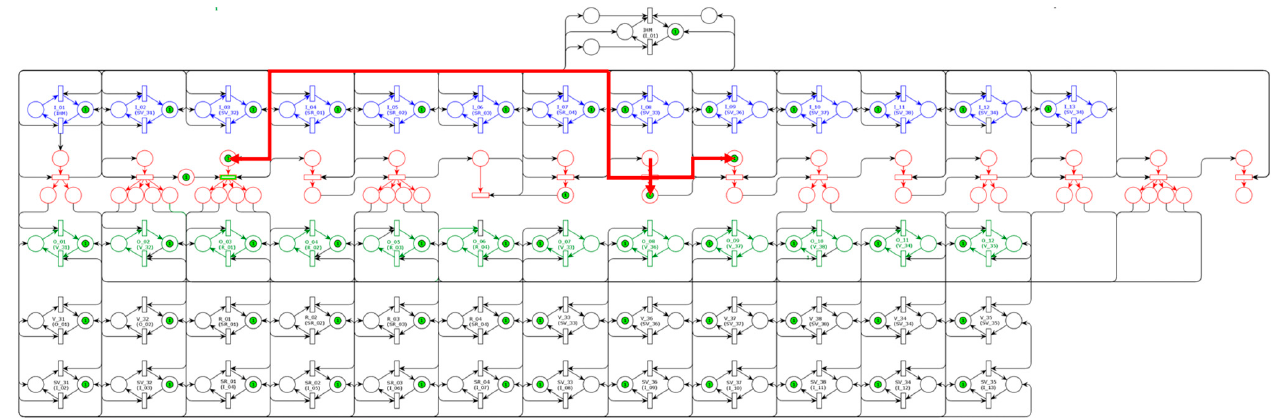
Figure 20. Algorithm’s seventh step—Load propellant lines.